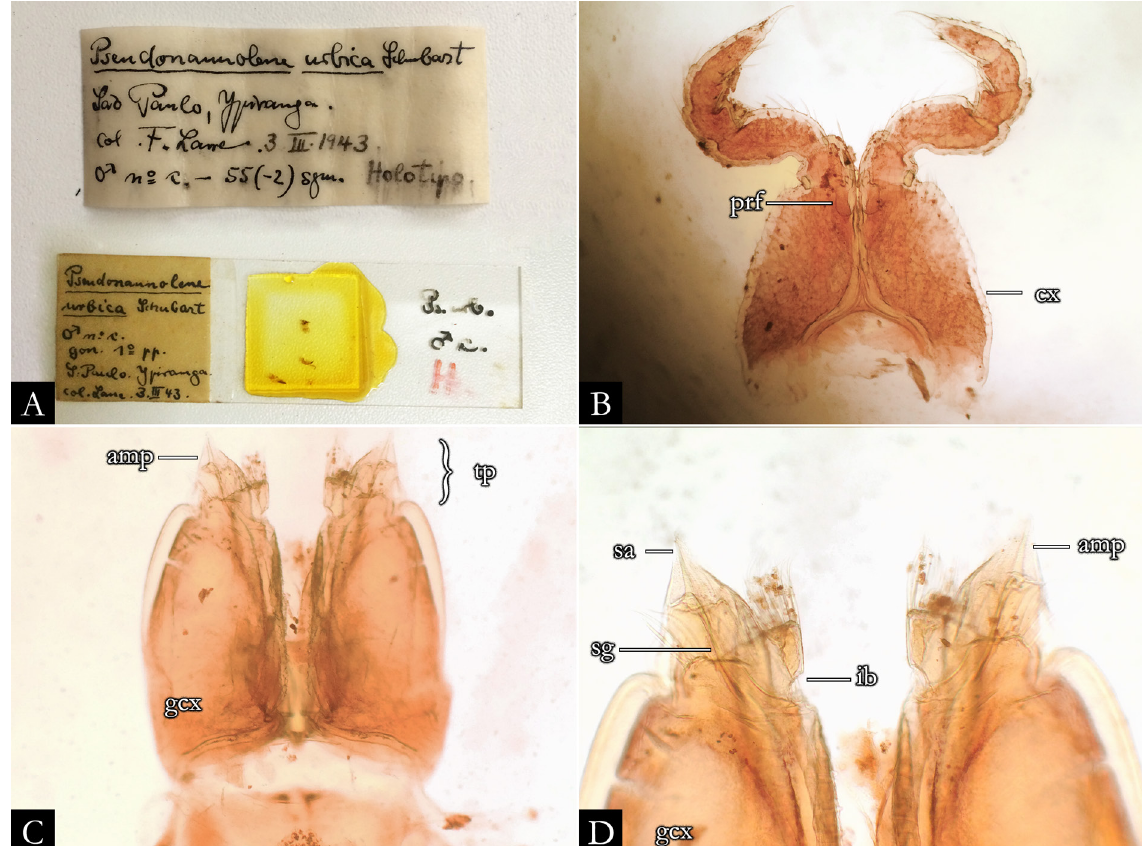
Fig. 142. Pseudonannolene urbica Schubart, 1945, holotype, ♂ (MZSP). A . Sexual structures of type material mounted on microscope slide. B . First leg-pair. C . Gonopods, in oral view. D . Detail of telopodites, in oral view. Abbreviations: see Material and methods. Images not to scale.